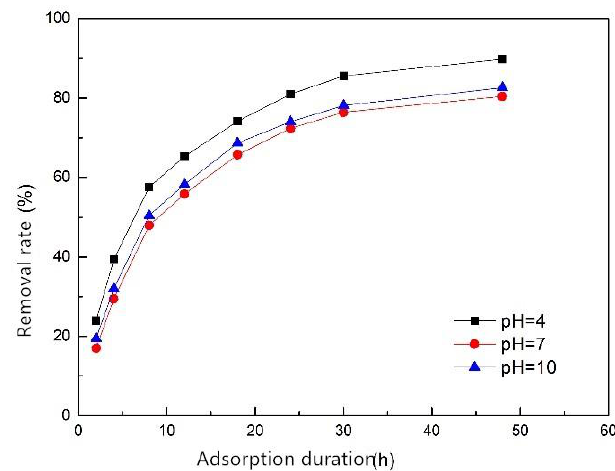
Figure 6. E ff ect of pH level on phosphorus removal e ffi ciency of ZSFB composite fiber. Figure 6. Effect of pH level on phosphorus removal efficiency of ZSFB composite fiber.